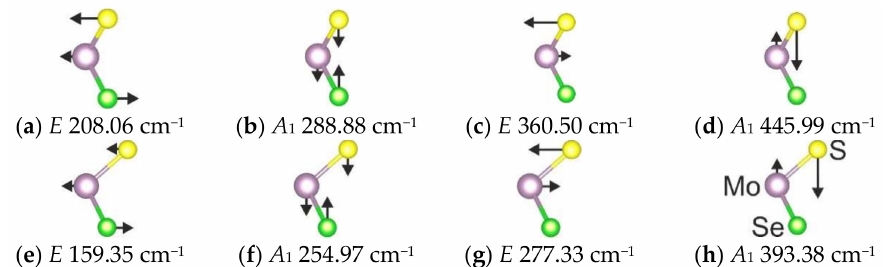
Figure 3. A schematic representation of vibrational modes of 1H ( a – d ) and 1T ( e – h ) MoSSe modifications. From the analysis of phonon density of states (Figure 4), we can infer that Se-related vibrations are dominant in low-wavenumber regions: below 290 cm − 1 for the 1H phase, and below 260 cm − 1 for the 1T phase (see Figure 4a,b, respectively). The molybdenum- involved vibrations are in all wavenumber ranges, and the sulfur translations are strong in the high-wavenumber range.